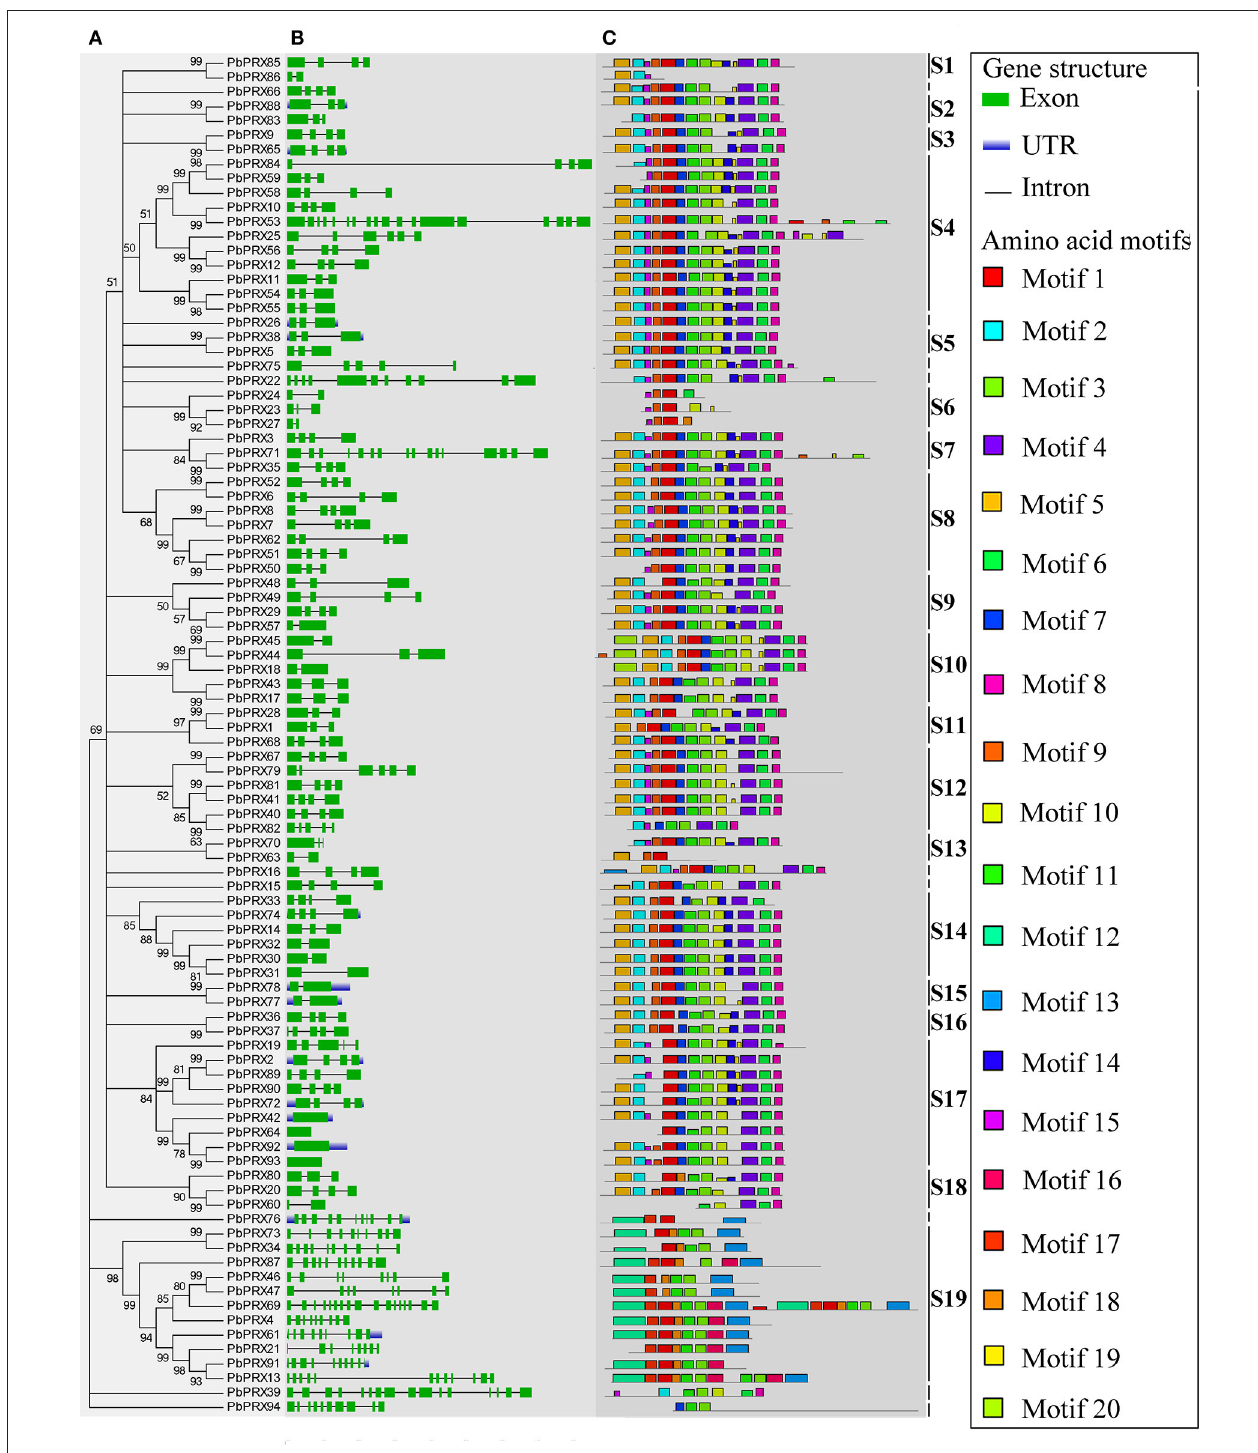
FIGURE 2 | Predicted Pyrus bretschneideri Rehd PRX (PbPRX) protein phylogeny, conserved motifs and exon–intron structure. (A) Unrooted Neighbour-Joining phylogeny of PbPRXs, with bootstrap values > 50. (B) Exon/intron organization of PbPRX gene models. (C) Distribution of amino acid motifs in pear PRX proteins. Exons, introns, and untranslated regions (UTRs) are indicated by green boxes, gray lines and blue lines, respectively. Relative protein or gene lengths can be estimated by gray bars.